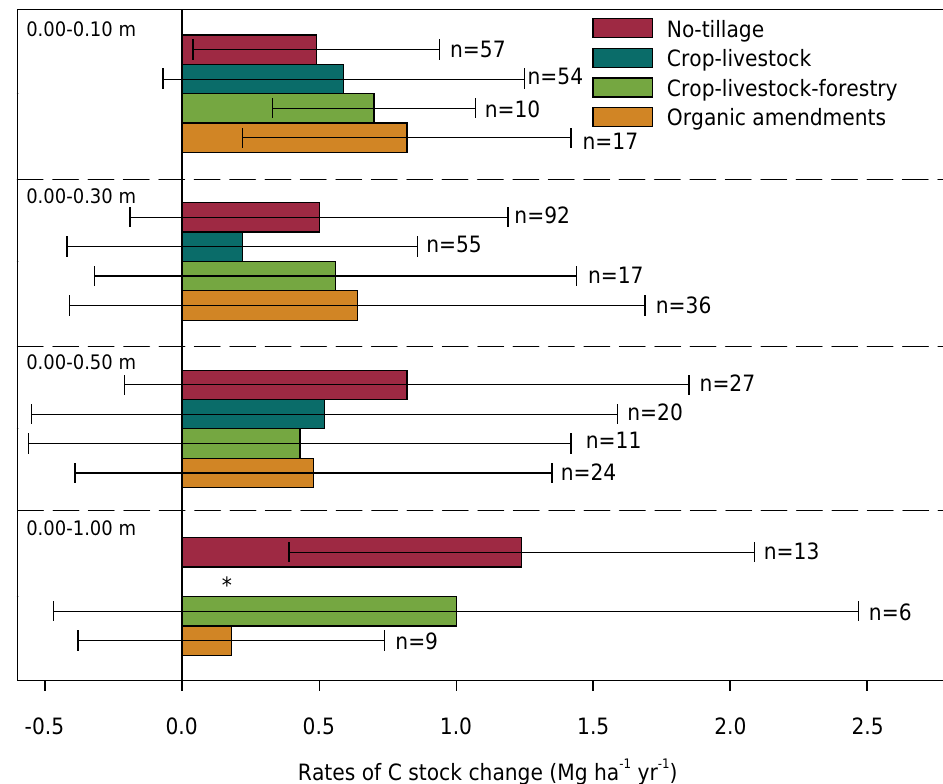
Rates of C stock change (Mg ha -1 yr -1 Figure 3. Rates of soil C stock change (Mg ha -1 yr -1 ) in croplands under climate-smart agriculture in Brazilian Cerrado at different soil layers (0.00–0.10, 0.00–0.30, 0.00–0.50 and 0.00–1.00 m). Bars represent the standard deviation of the mean values, and “n” is the number of data pairs. *: There was no data for soil C changes in crop-livestock systems at 0.00-1.00 m depth.